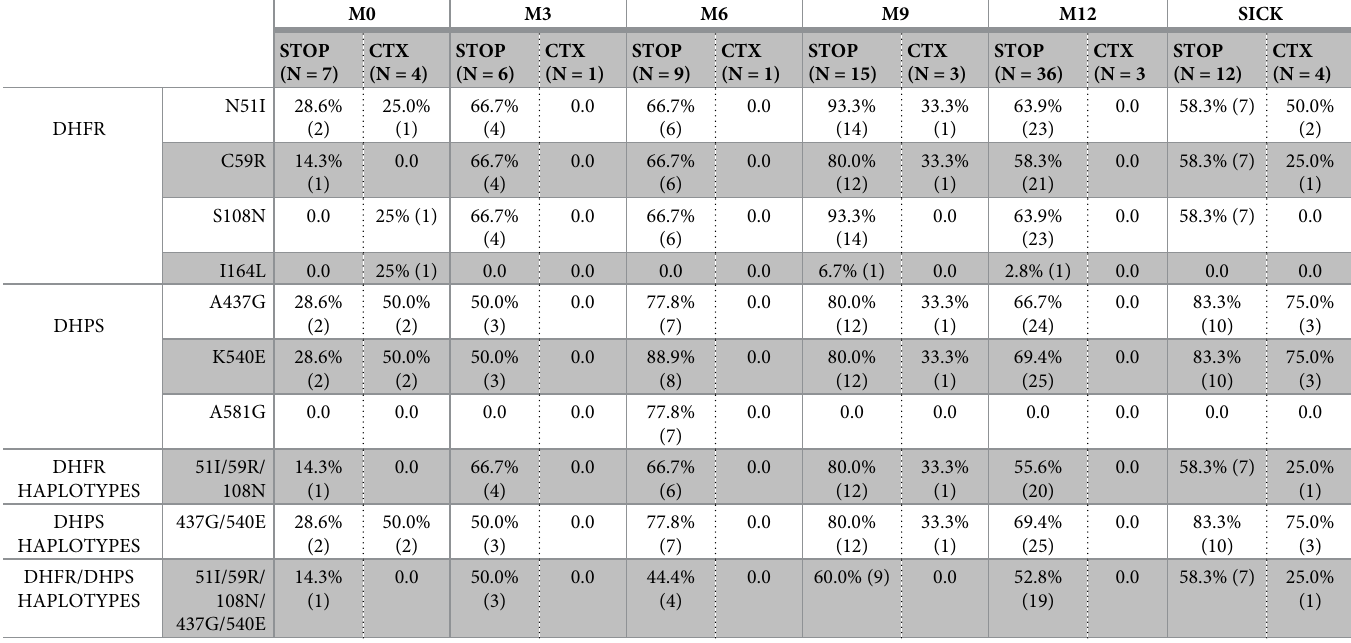
Fig 1. Prevalence of haplotype mutations in pfdhfr and pfdhps genes in subjects continuing with cotrimoxazole prophylaxis therapy (CTX) and those who stopped CTX therapy (STOP CTX). The prevalence was based on the total number of P . falciparum positive samples in each arm. The statistical difference in parasite prevalence between the two arms was determined. A) Haplotype mutations (51I, 59R, 108N and 164L) in pfdhfr gene; B) haplotype mutations (437G, 540E and 581G) in pfdhps gene and; C) haplotype mutations present in both genes. There were statistical significant differences between the STOP CTX and CTX arms in the pfdhfr gene haplotype 51I/59R/ 108N (P = 0.0006), in pfdhps gene haplotype 437G/540E (P = 0.027) and in both genes haplotype 51I/59R/108N/437G/540E (P = 0.0007).